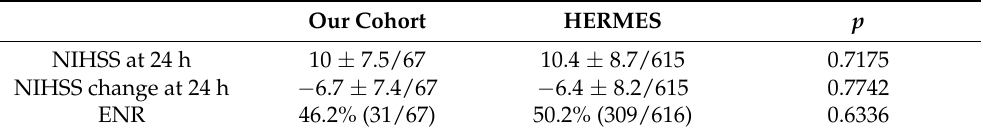
Table 3. Comparison of early efficacy outcomes (mean NIHSS score at 24 h, change in mean NIHSS score from baseline to 24 h, early neurological recovery at 24 h).